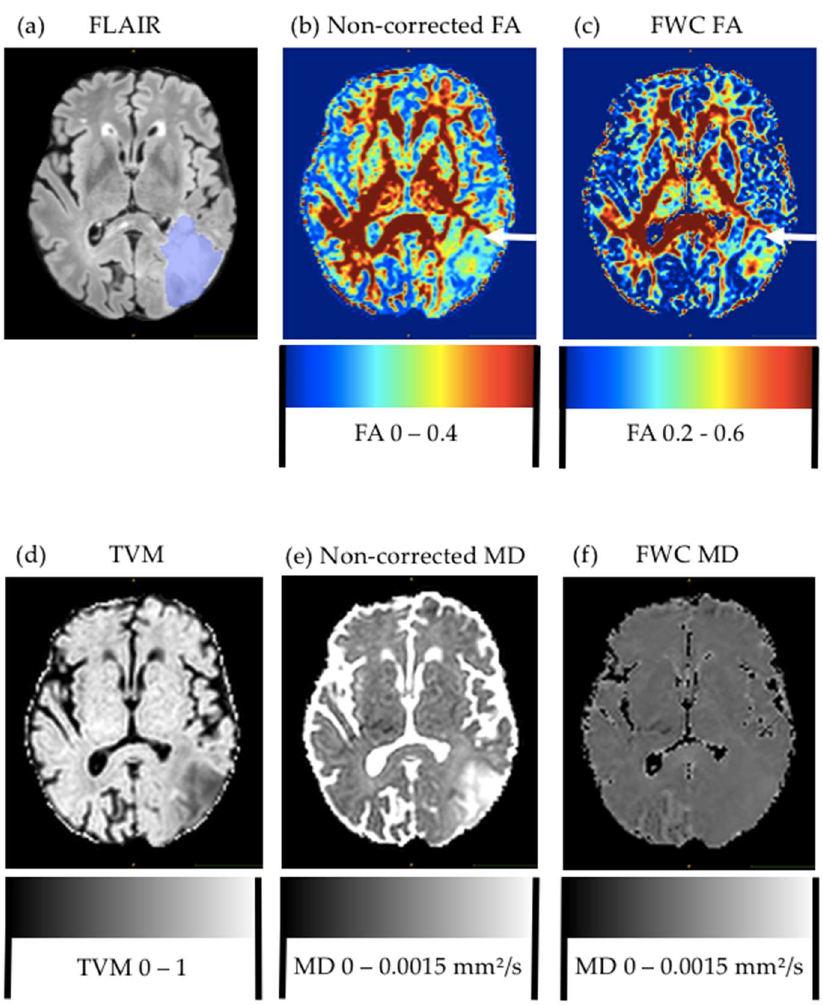
Figure 1. Comparison of metrics for glioblastoma patient. Preoperative FLAIR ( a ) with edema segmentation (overlaid in blue), and ( b ) noncorrected and ( c ) free-water-corrected fractional-anisotropy (FA) maps. Arrow in both FA maps points to area of later tumor recurrence. For improved visualization, display windows were adapted. ( d ) Tissue-volume map with generally lower values in peritumoral edema, but no significant differences between pure edema and edema with later recurrence. Mean-diffusivity map ( e ) before and ( f ) after free-water correction, which noticeably decreased contrast.